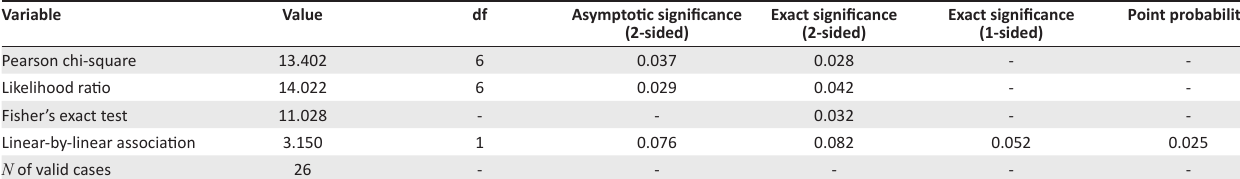
TABLE 3: Results of chi-square tests. Variable